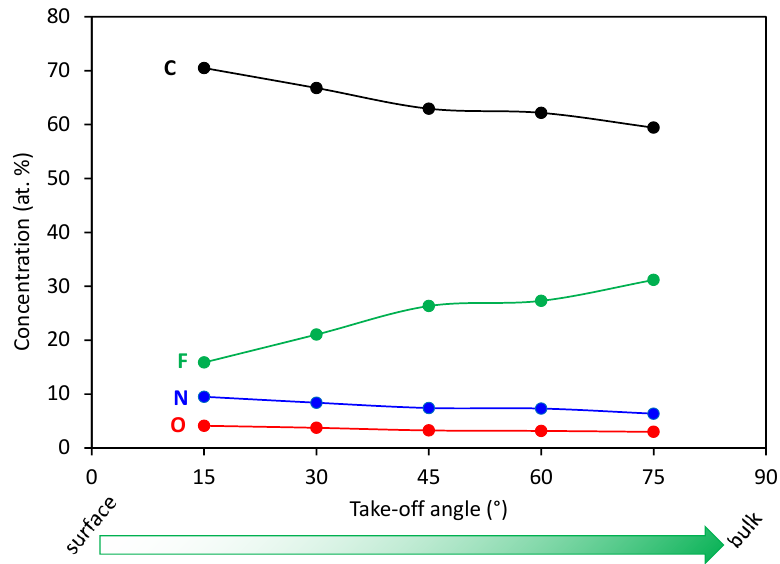
Figure 7. Variation of the surface composition of the sample treated for 10 s at 200 W versus the take-off angle (i.e., different detection depth).